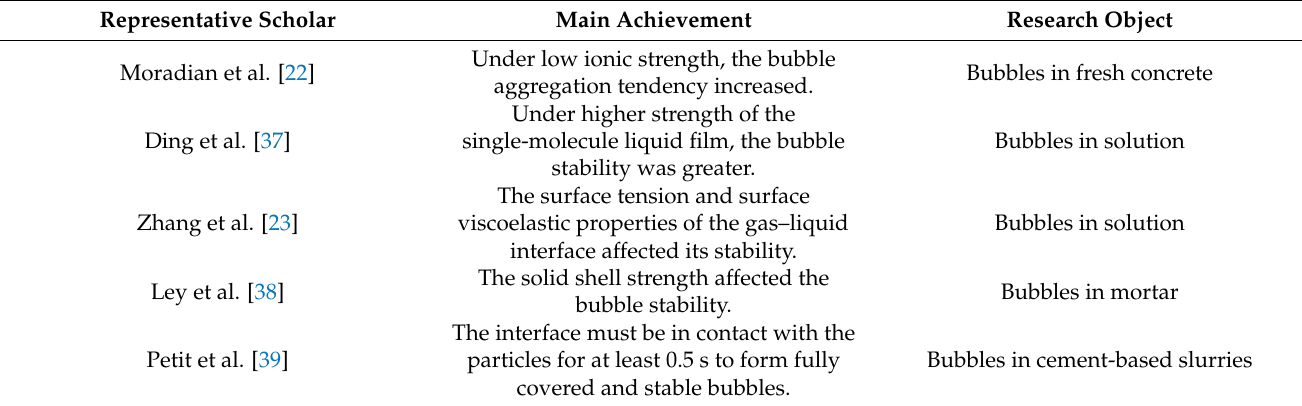
Table 2. Representative results of the bubble stability